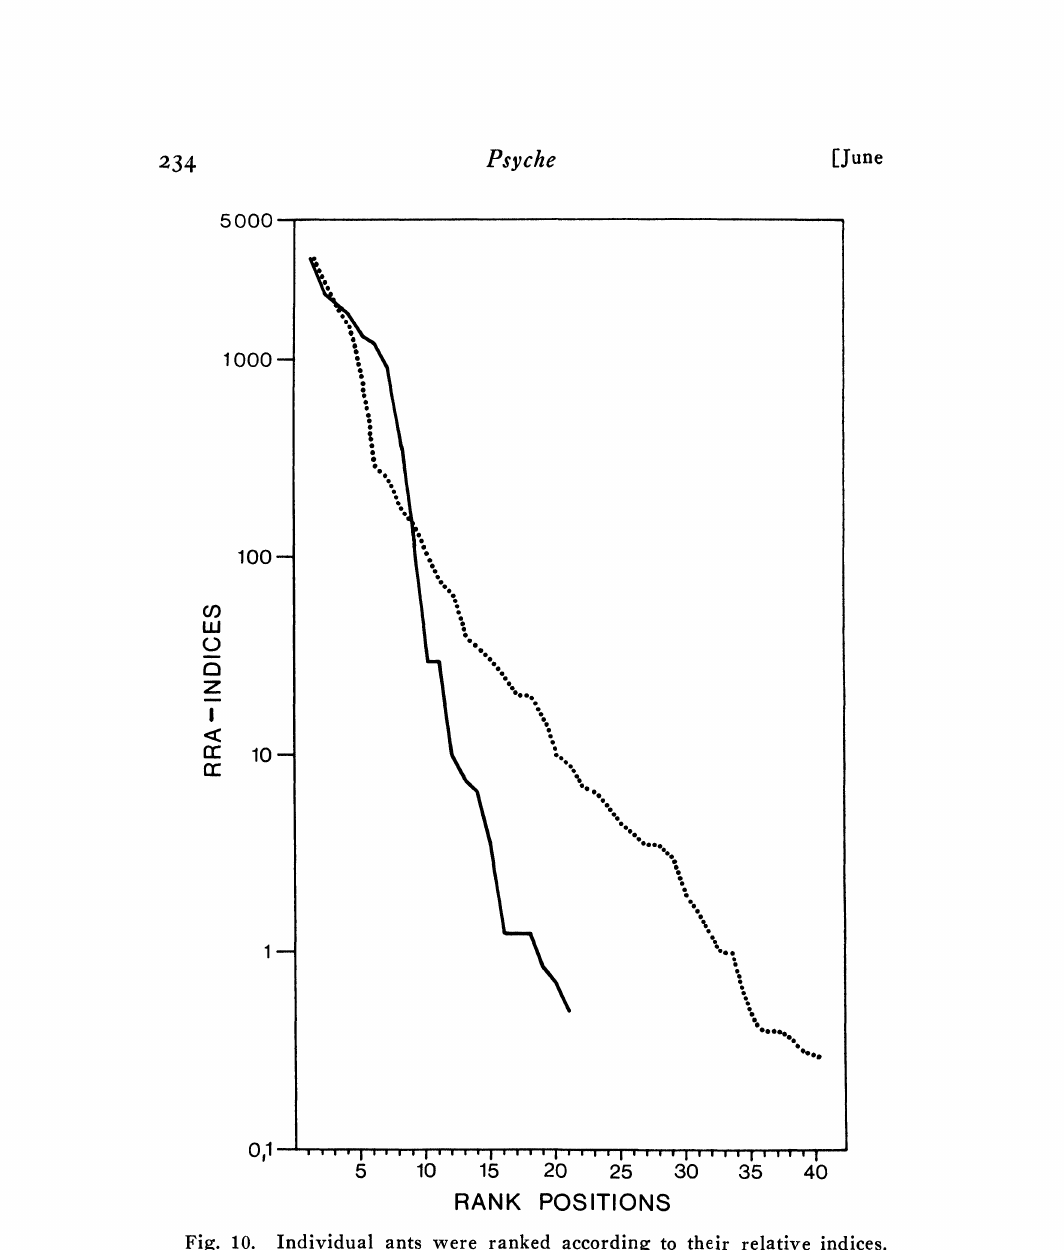
Fig. 10. Individual ants were ranked according to their relative indices. The rank positions (abscissa) are plotted against the index values (ordinate, logarithmic). The steepness of the curve directly represents the degree of specialization of the worker group. Dotted line: Camponotus sericeus; solid line: Formica